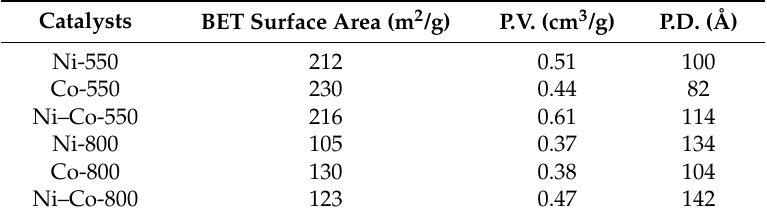
Figure 2. N 2 adsorption-desorption isotherms for fresh Ni and/or Co-based catalysts ( a ) calcined at 550 °C and ( b ) calcined at 800 °C. Table 1. BET surface area, pore volume (P.V.) and pore diameter (P.D.) of fresh Ni and/or Co-based catalysts calcined at 550 °C and 800 °C.